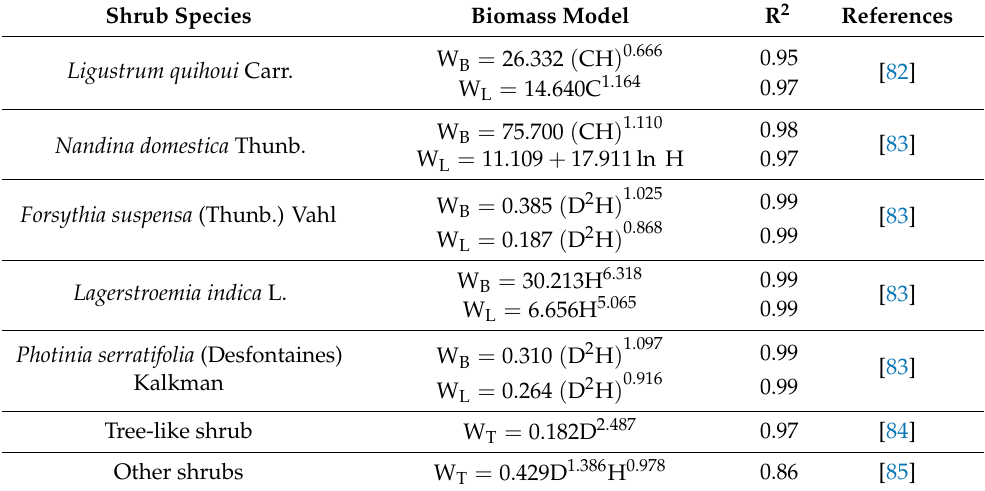
Table A2. Shrub allometric growth equation for calculating quadrat above-ground biomass of shrubs.